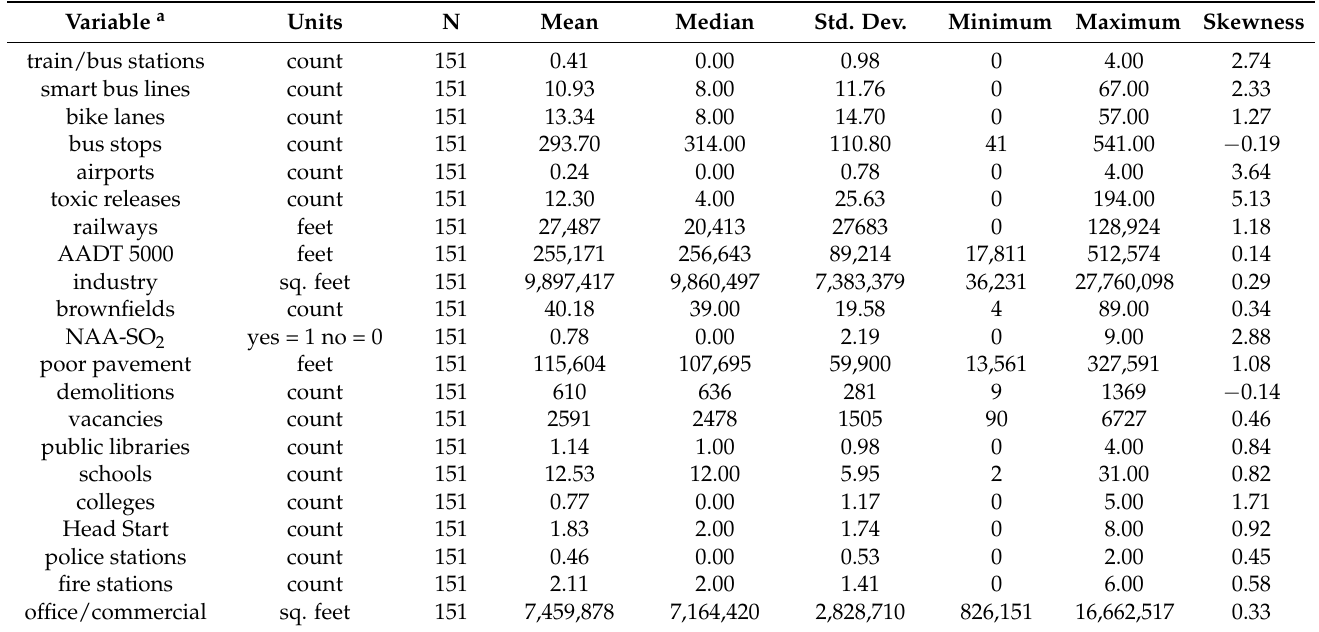
Table 2. Descriptive statistics of all potential explanatory variables based on data in the buffer